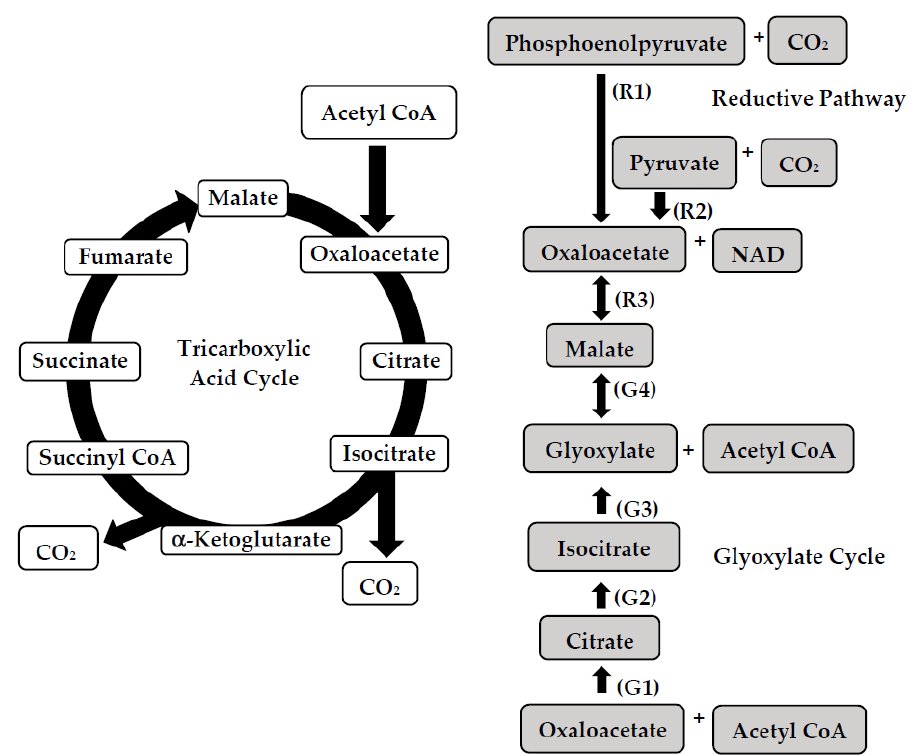
Figure 1. Three metabolic pathways in microorganisms utilized to synthesize malic acid. The tricarboxylic acid cycle which forms malate oxidatively is indicated on the right. The reductive pathway (R) of malic acid synthesis involves phosphoenolpyruvate carboxykinase (R1), pyruvate carboxylase (R2) and malate dehydrogenase (R3). The glyoxylate cycle (G) pathway enzymes include citrate synthase (G1), aconitase (G2), isocitrate lyase (G3) and malate synthase (G4). The tricarboxylic acid pathway is mitochondrial (no shading) while the reductive and glyoxylate cycle pathways are cytosolic (shaded in gray).